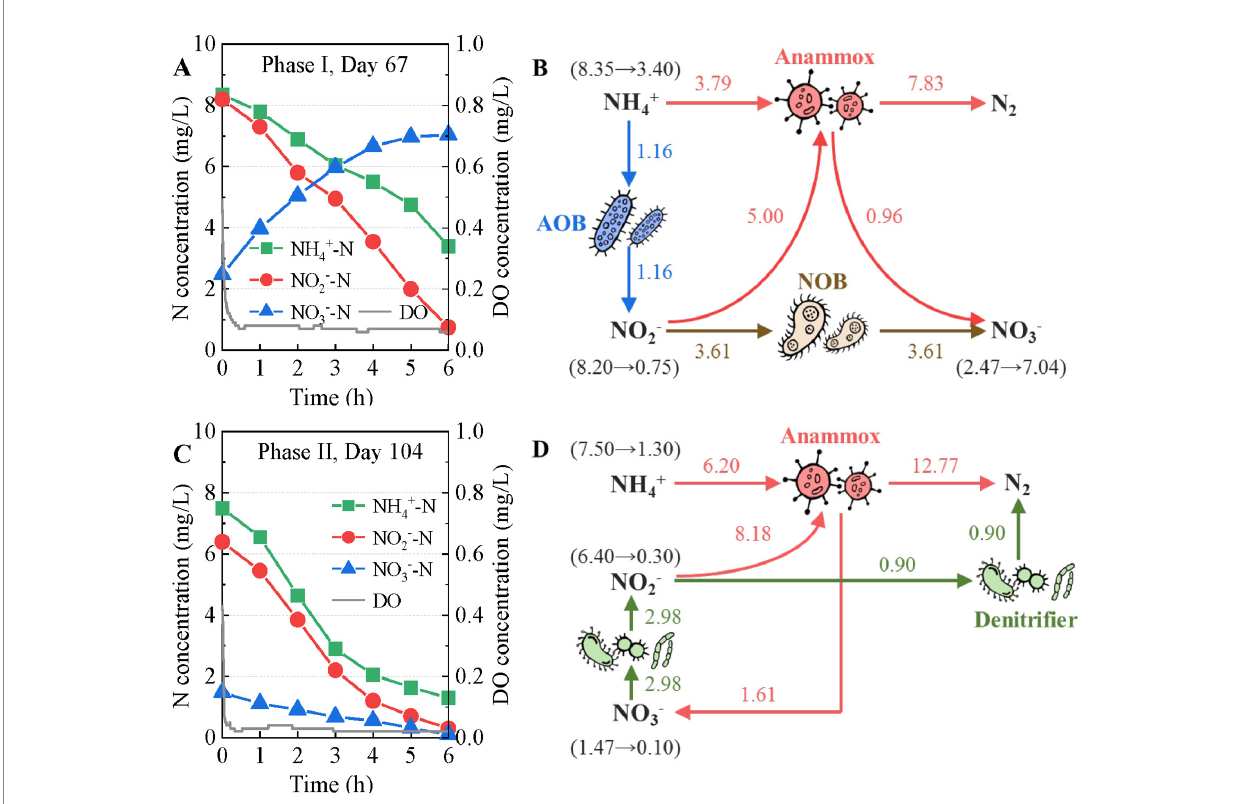
FIGURE 3 Variations in N-compound concentrations ( A : phase I, C : phase II) and nitrogen transformation pathways ( B : phase I, D : phase II) in the typical cycles of the mainstream anammox